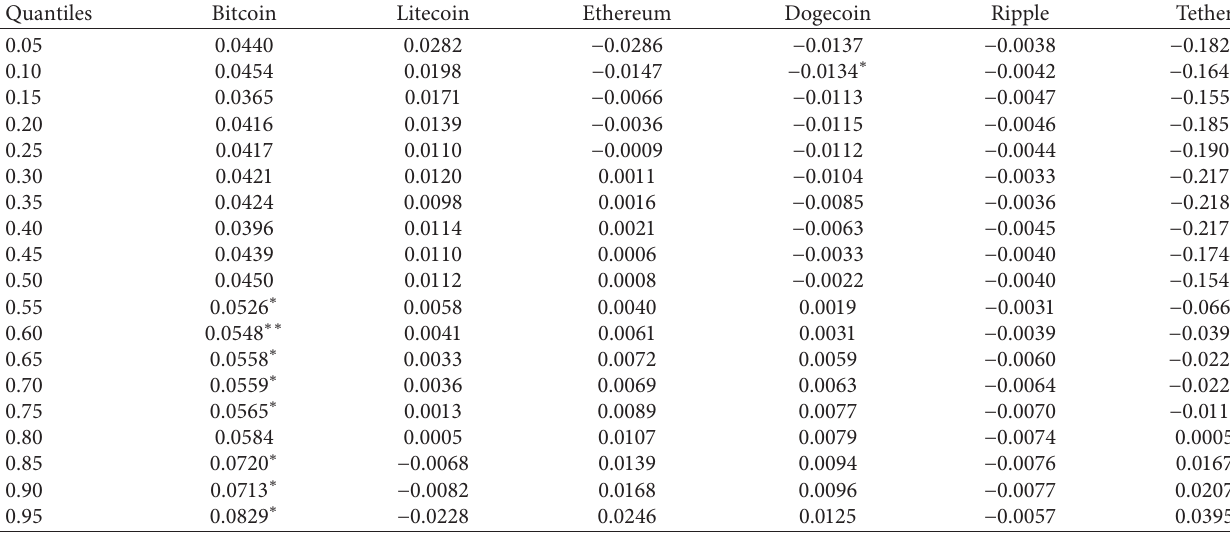
Table 3: Quantile regression results of signal.